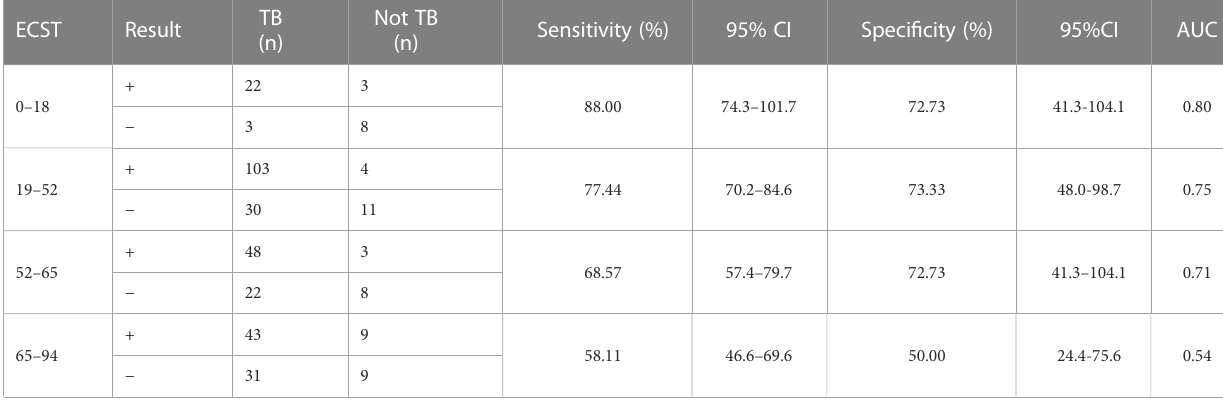
TABLE 5 Comparison of the accuracy of the ECST in patients of different ages with clinically diagnosed tuberculosis. ECST